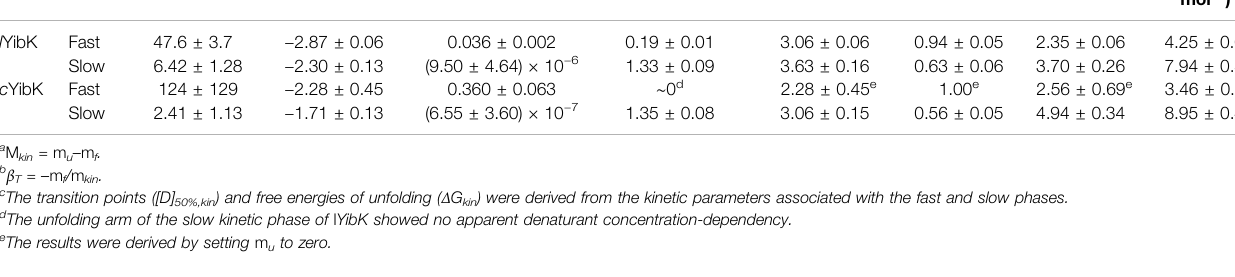
TABLE 1 | Kinetic parameters derived from chevron plot analysis of l YibK and c YibK. Kinetic